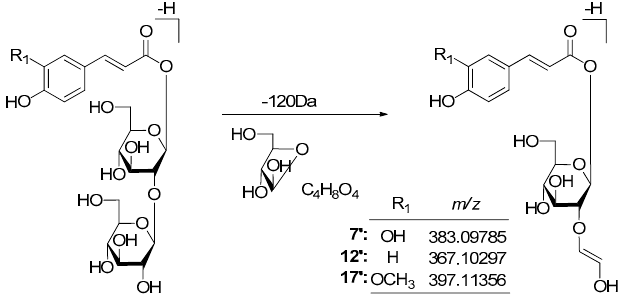
Figure 13. The proposed fragmentation pathways of β - D -glucopyranosyl(1 → 2)- β - D -glucopyranosyl substituted phenolic acid glycosides.